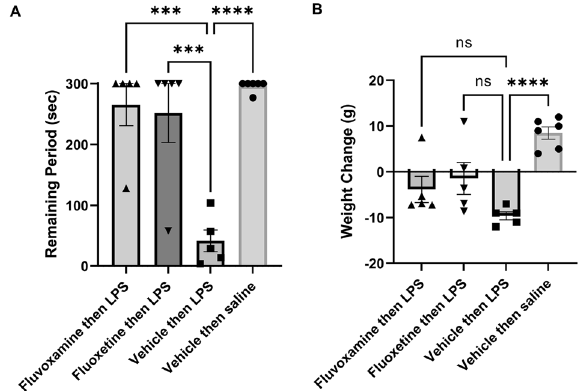
Fig. 6 Fluvoxamine and fl uoxetine prevent memory impairment by LPS. A The graph depicts the time that animals remained in the lit chamber on the day following conditioning during a 5 min trial. When administered 1 h prior to LPS followed by conditioning in a one-trial inhibitory avoidance task, both fl uvoxamine (10 mg/kg i.p.) and fl uoxetine (10 mg/kg i.p.) prevented the adverse effects of LPS